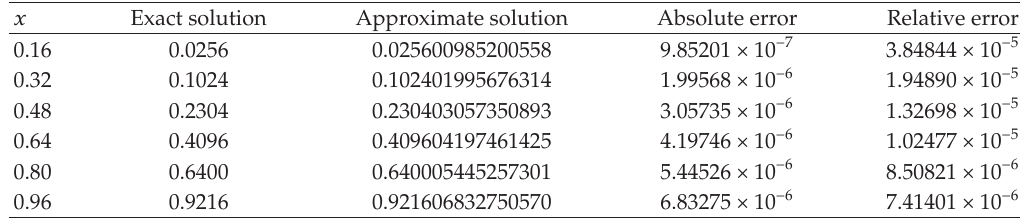
Table 1: Numerical results for Example 5.1.